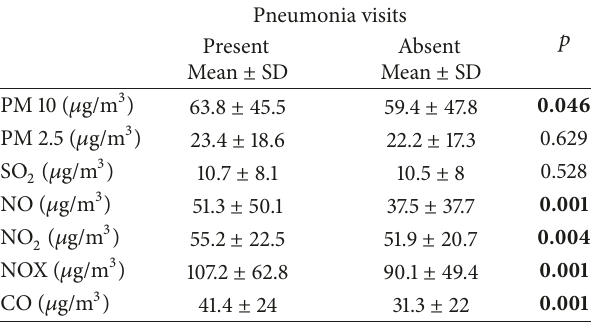
Table 4: Relationship between pneumonia visits and air pollution parameters.